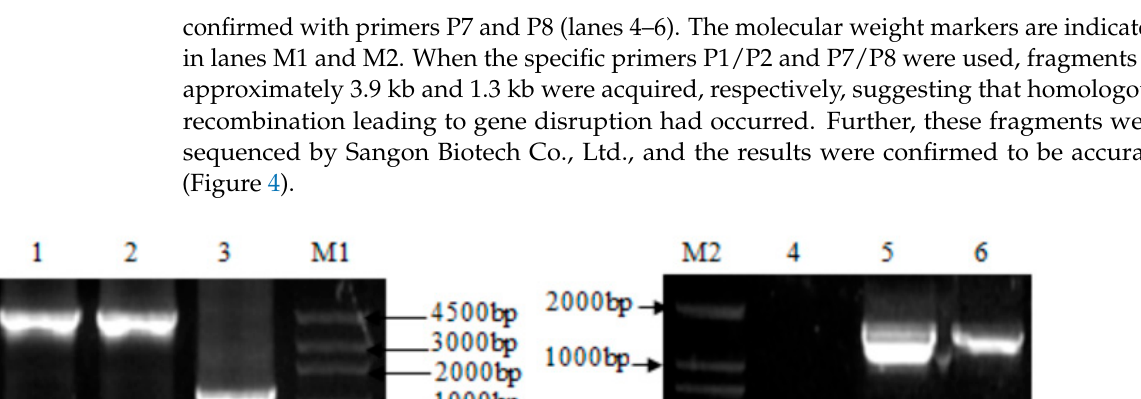
Figure 3. Schematic diagrams of strategy for disruption of F. oxysporum aldh in this study.